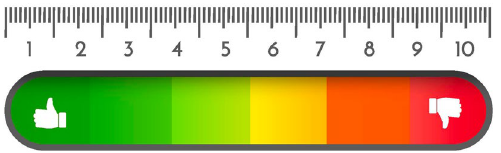
Figure 4. Visual Analog Scale—a special (colored) ruler for pain assessment [own